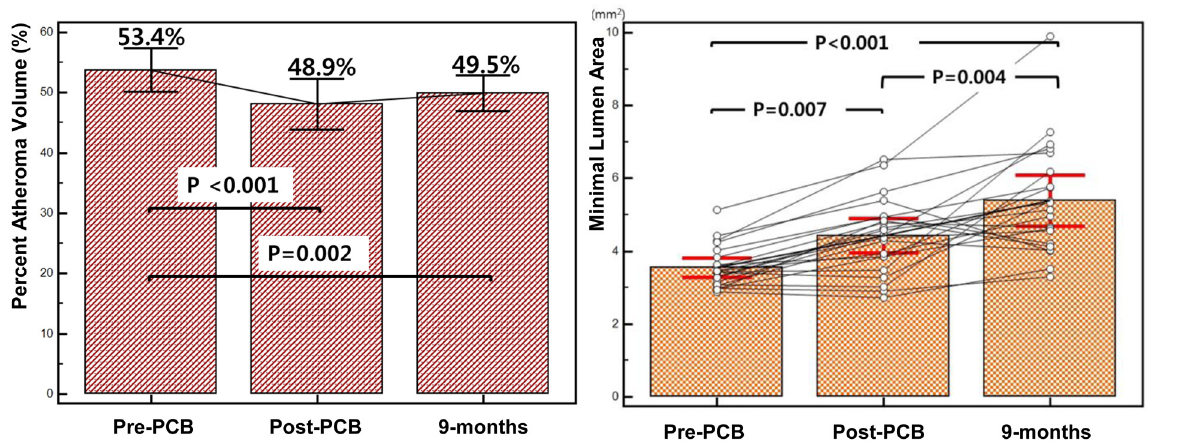
Fig 2. Serial changes in percent atheroma volume and minimal lumen areas.